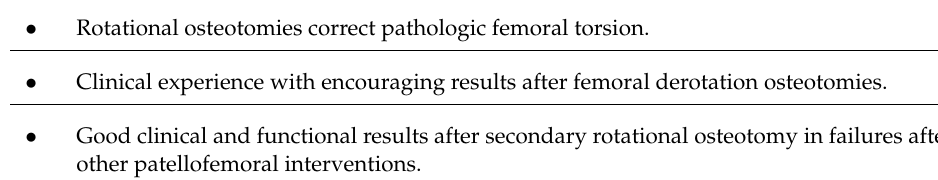
Table 2. Main arguments for rotational